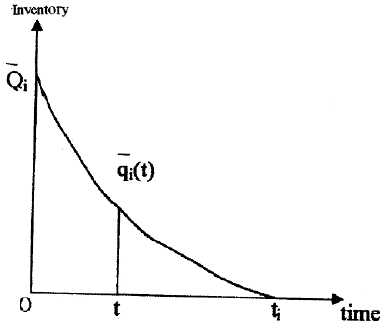
Figure 4. Inventory ends with neither shortage nor stock.